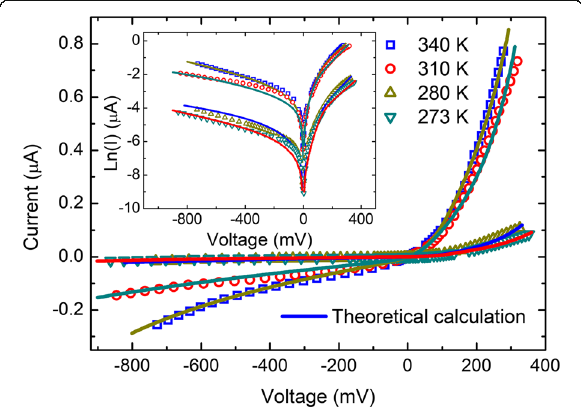
Fig. 6 EDS data of ReSe 2 is on the top right corner of the image. Boxes 1 and 2 represent two measured sections